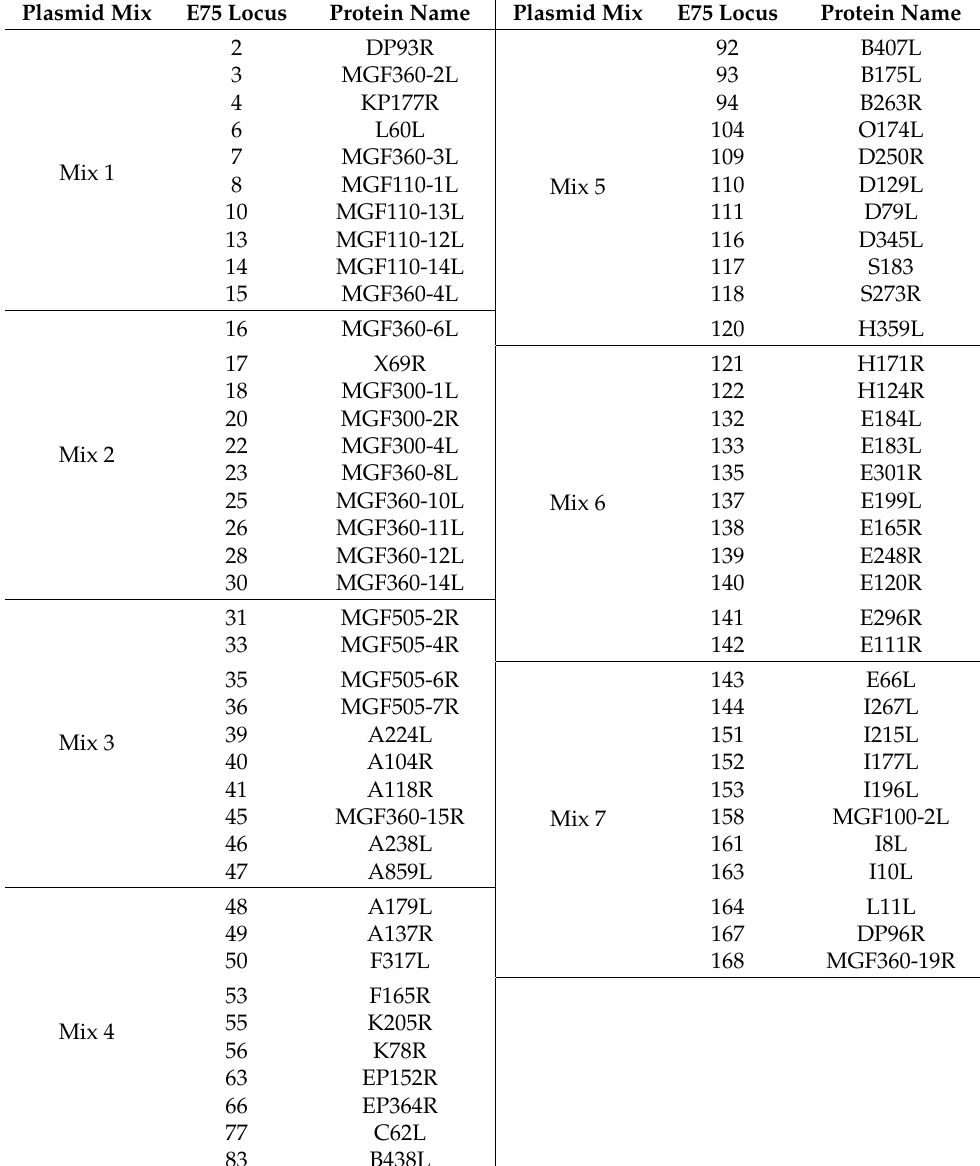
Table 4. E75 ASFV gene expression library encoding each open reading frame (ORF) with the ubiquitin gene at the N-terminus and under the control of the CMV